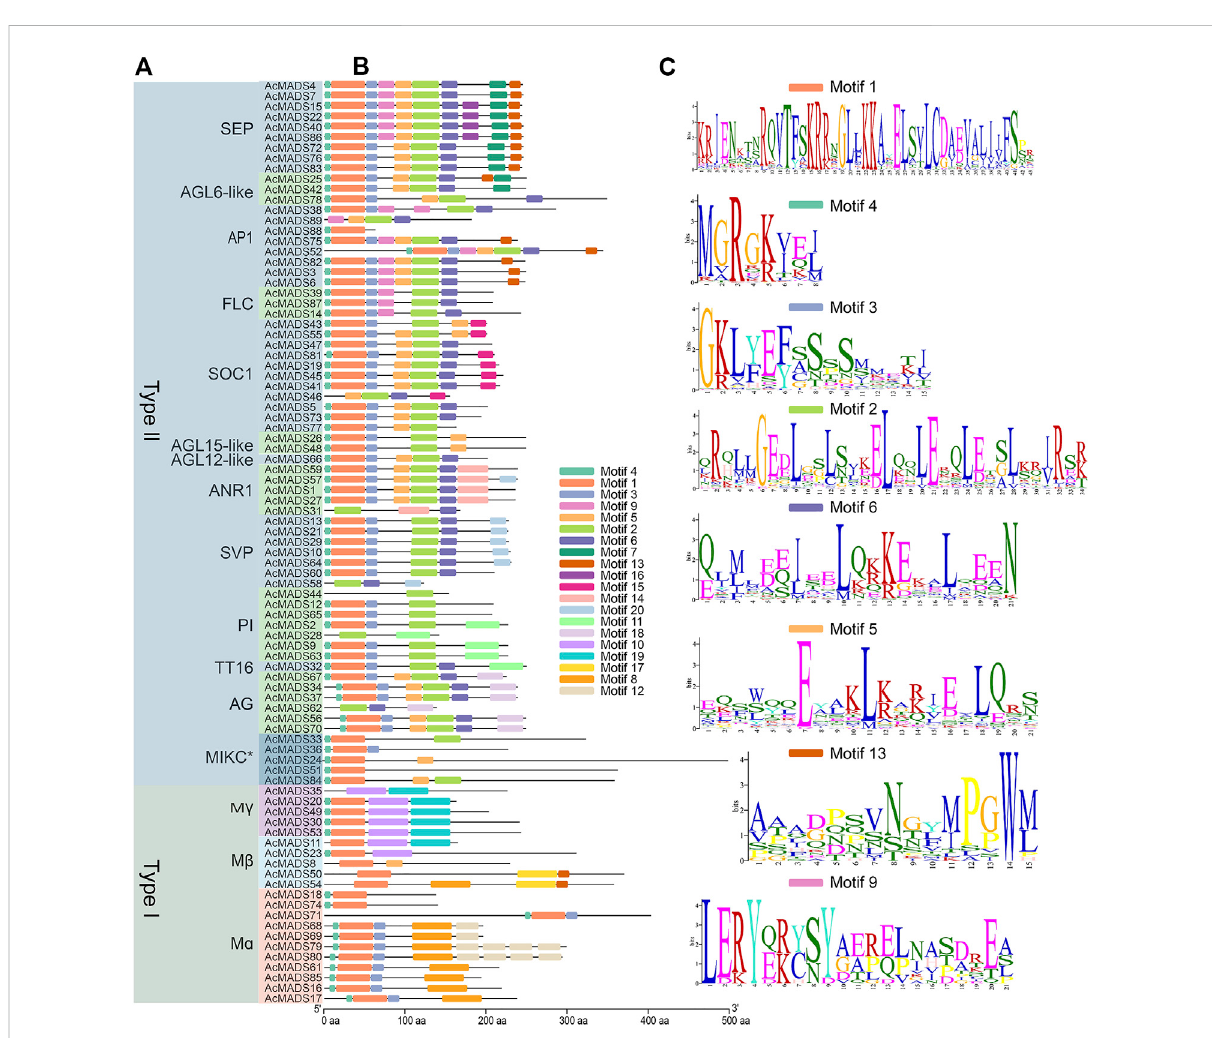
FIGURE 4 Protein motifs of MADS-box genes from A. chinensis . (A) The phylogenetic tree of 89 AcMADS-box proteins. (B) Motif locations of the 89 AcMADS-box proteins. The 20 types of motifs are shown with different colors boxes. (C) Sequence logos of the top 8 motifs with the largest number of genes. The details of each motif are listed in Supplementary Table